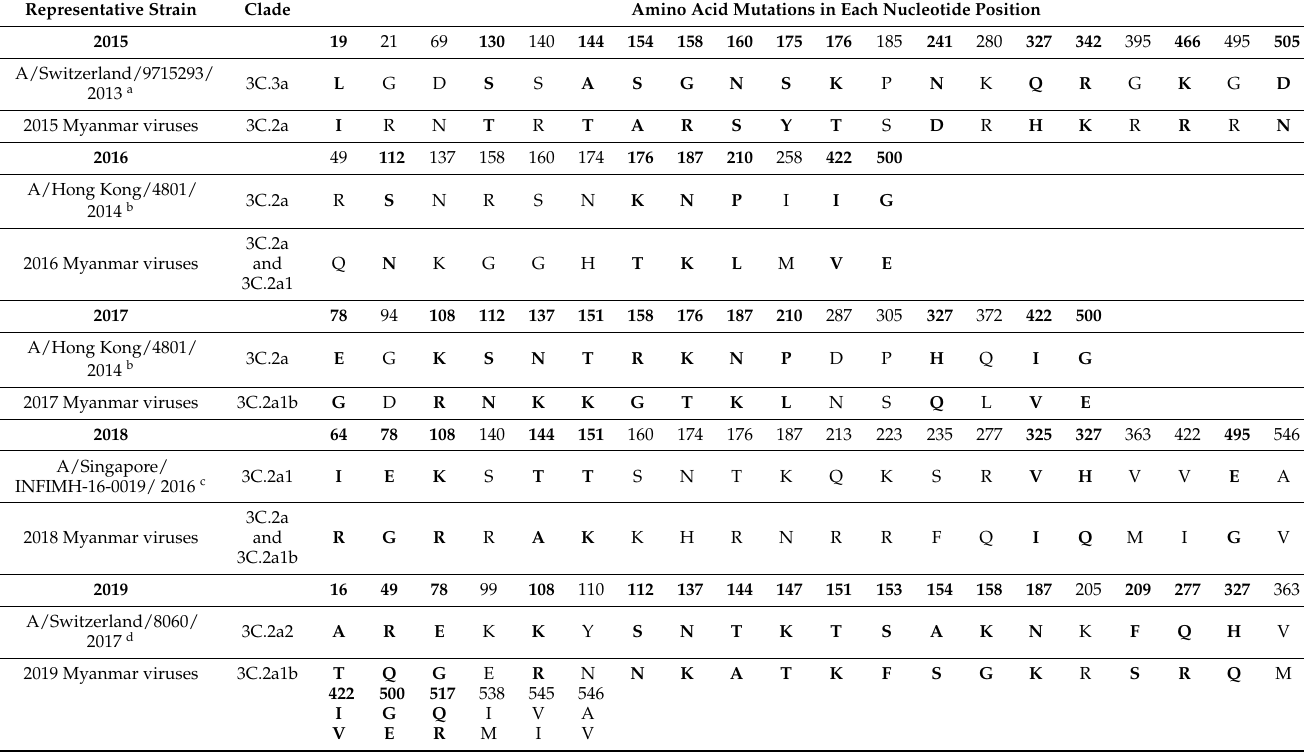
Table 1. List of mutation differences in HA gene between Southern Hemisphere vaccine strains and Myanmar 2015–2019